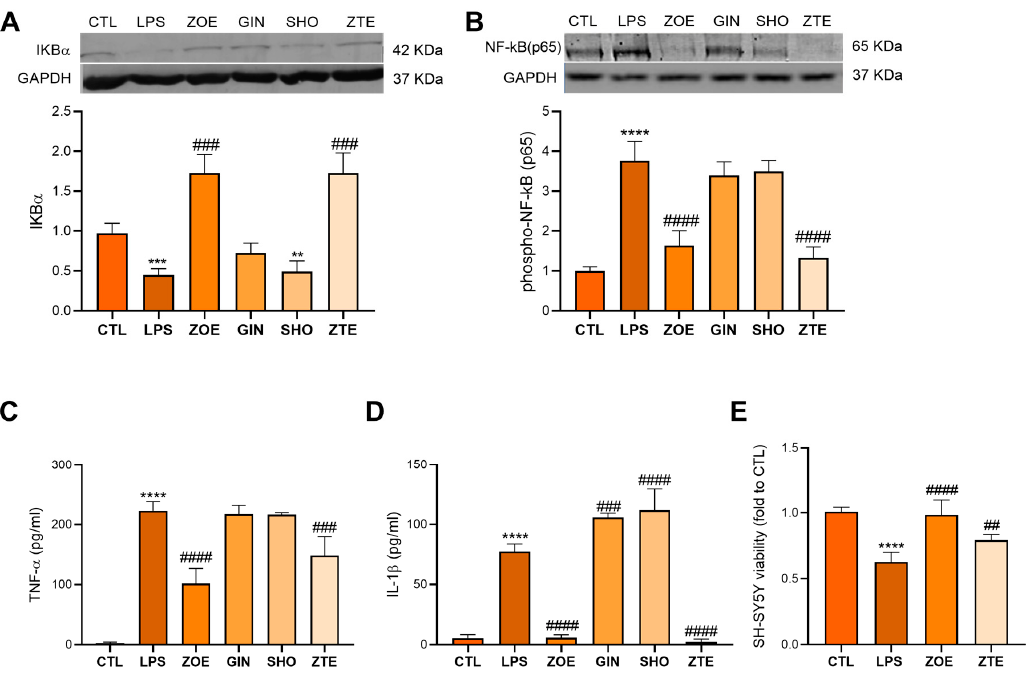
Figure 1. Anti-inflammatory effects of ZOE and ZTE in BV2 cells. Modulation by ZOE (10 µ g/mL), GIN (1 µ g/mL), SHO (0.17 µ g/mL) and ZTE (3 µ g/mL) of IKB- α ( A ) and phospho-NFkBp65 ( B ) protein levels in LPS-stimulated BV2 cells. Effect of ZOE (10 µ g/mL), GIN (1 µ g/mL), SHO (0.17 µ g/mL) and ZTE (3 µ g/mL) on the release of TNF- α ( C ) and IL-1 β ( D ) by LPS-stimulated BV2 cells. Protective effect of ZOE (10 µ g/mL), and ZTE (3 µ g/mL) on the neurotoxic effect induced by LPS-conditioned BV2 medium ( E ). Asterisks (*) indicate significance versus CTL; (#) indicates significance versus BV2 + LPS; two symbols, p < 0.01; three symbols, p < 0.001; four symbol, p < 0.0001.